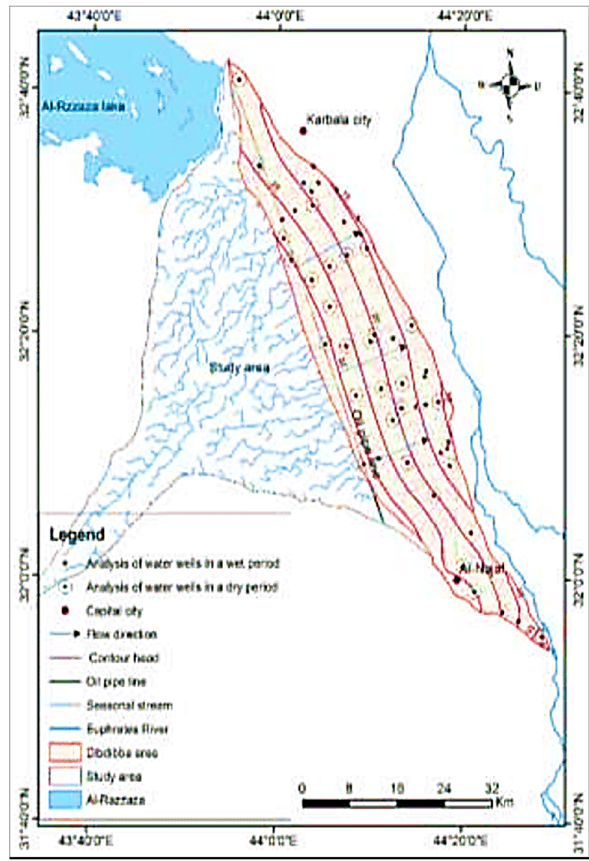
Figure 2: Location of wells in Najaf and Kerbala plateau ( Al - kubaisi et al. [ 11 ]) .